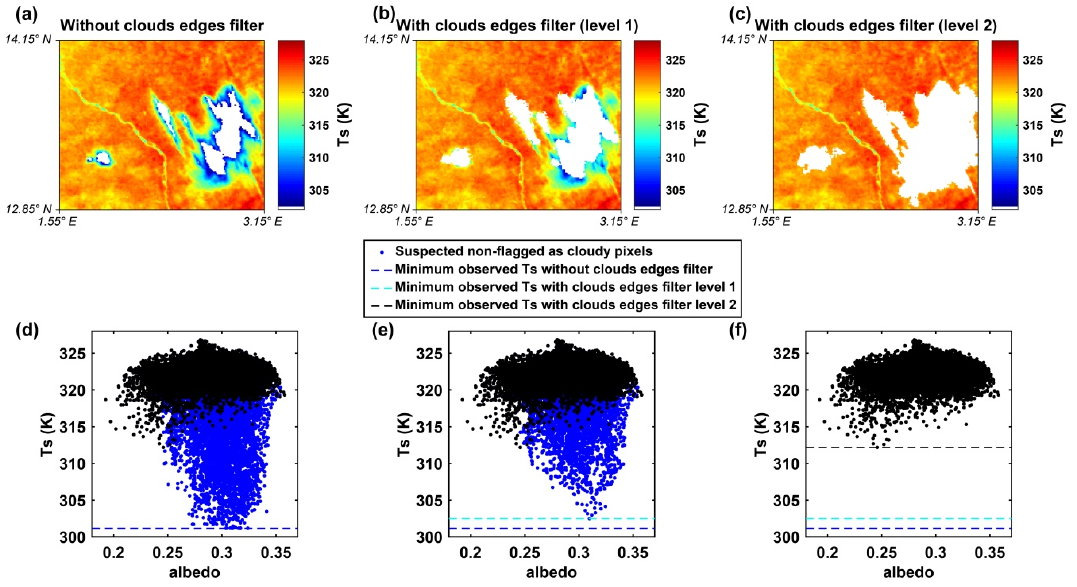
Figure A1. Ts maps obtained with di ff erent levels of cloud filtering for 17 May 2005 ( a − c ), and corresponding Ts-albedo scatterplots ( d – f ). ( a , d ): no cloud edge filter but the MODIS cloud mask (masked areas in white); ( b , e ): application of the first level Ts filter; ( c , f ): application of the first and second level Ts filters.